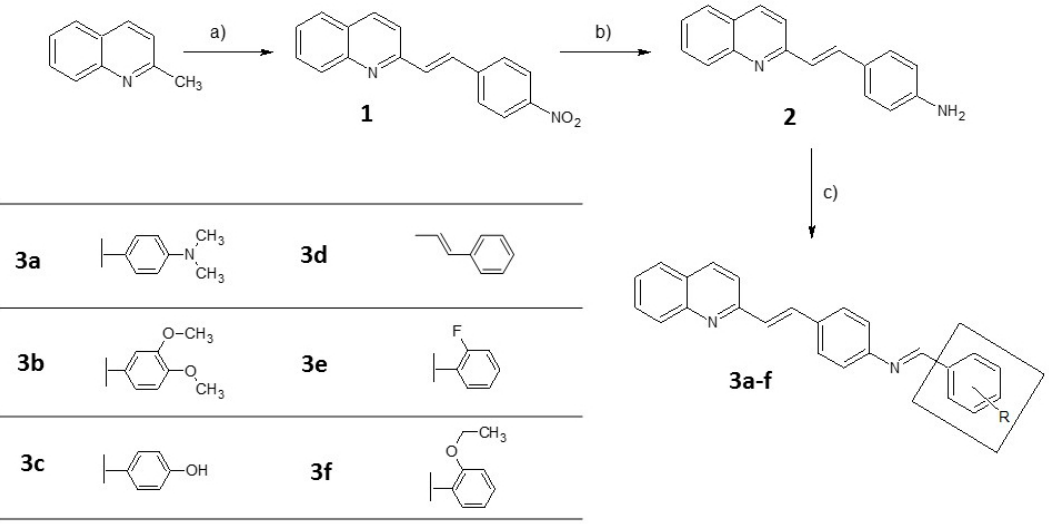
Figure 2. The synthetic pathway of compounds 3a – f . Reagents and conditions: ( a ) Aromatic aldehyde/Ac 2 O, b ) SnCl 2 /EtOH, and c) aromatic aldehyde/EtOH.